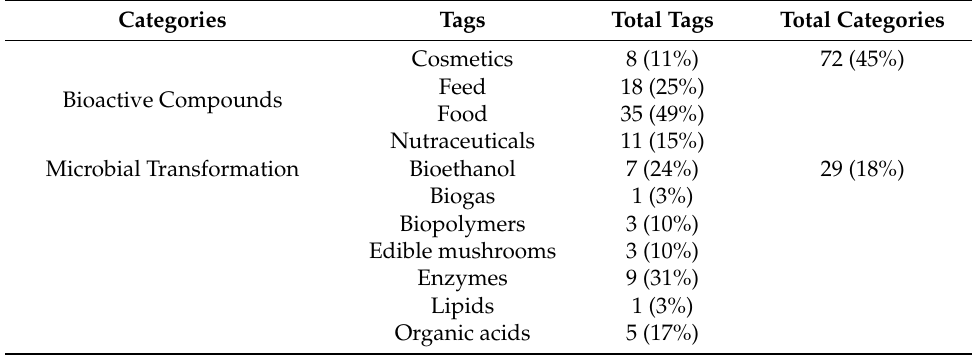
Table 2. Categories and tags proposed to identify by-products applications.